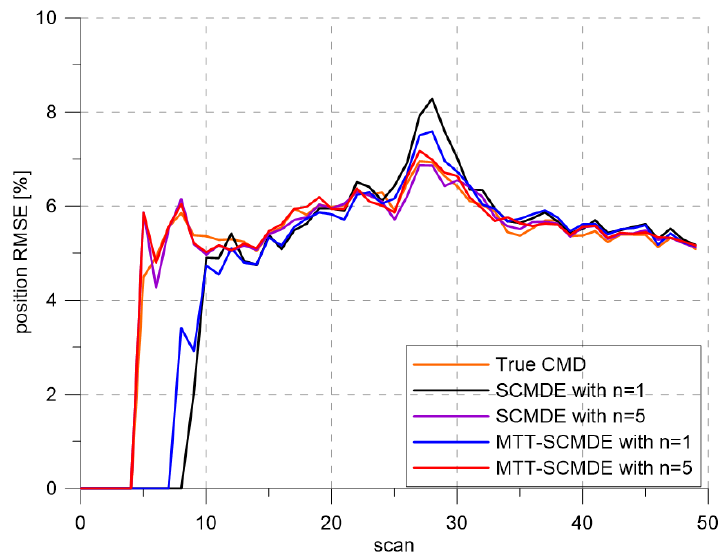
Figure 5. Position